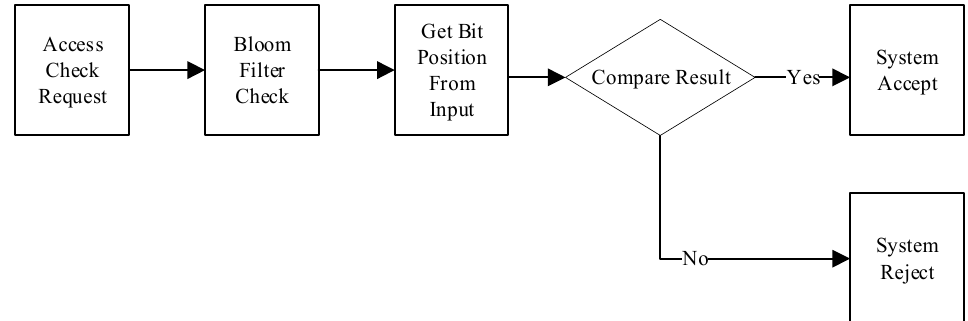
Figure 6. Flow diagram of the access control based on bloom filter.